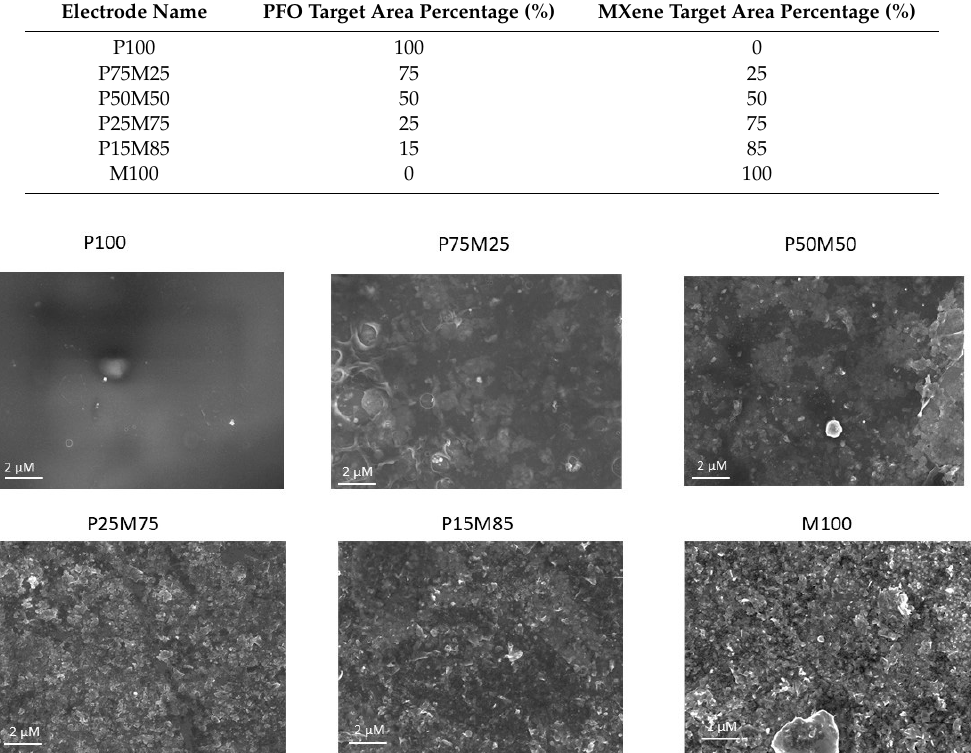
Figure 1. SEM images of di ff erent film compositions deposited in RIR-MAPLE, labeled according to Table 1. MXene flakes appear as bright white regions within each of these films, while the darker regions are the PFO matrix. The naming scheme is as follows: PxxMyy, where xx and yy indicate the area percentage within the RIR-MAPLE frozen emulsion target for PFO and MXene,